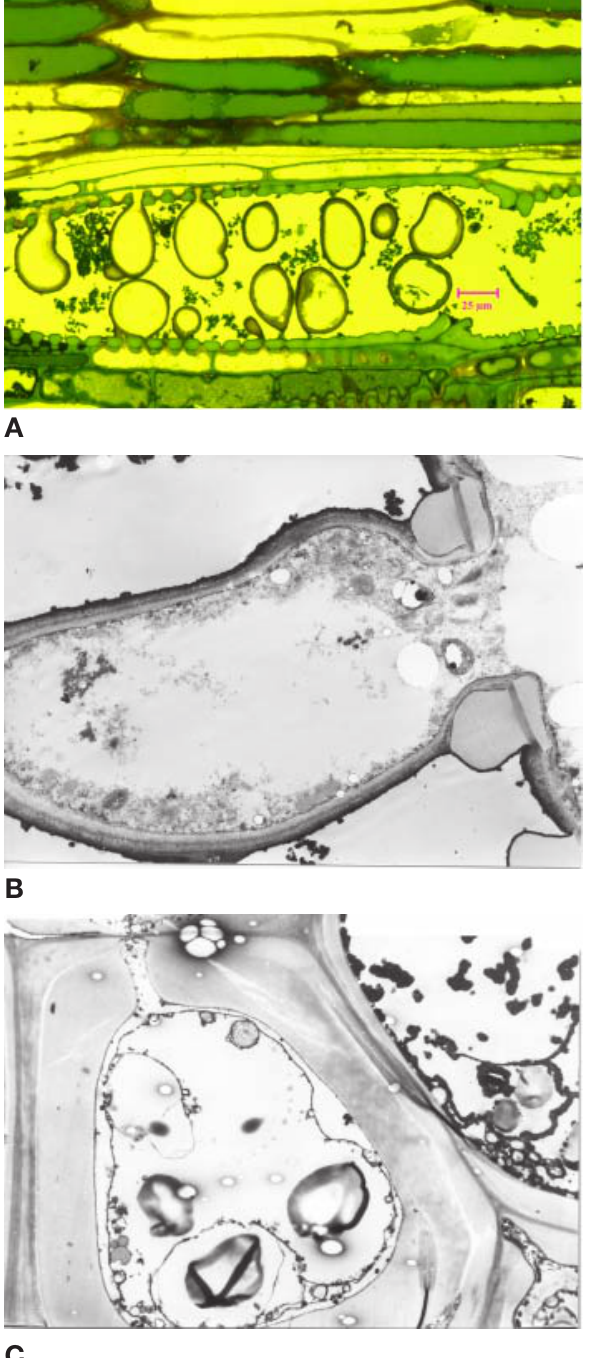
Fig. 2. A. Magnified longitudinal section of infected SO4 vine roots. B. Electron microscopy of a tylose formation in the xylem lumen ( (cid:1) 3,150). C) Electron microscopy of a mature tylose in the xylem lumen ( (cid:1)